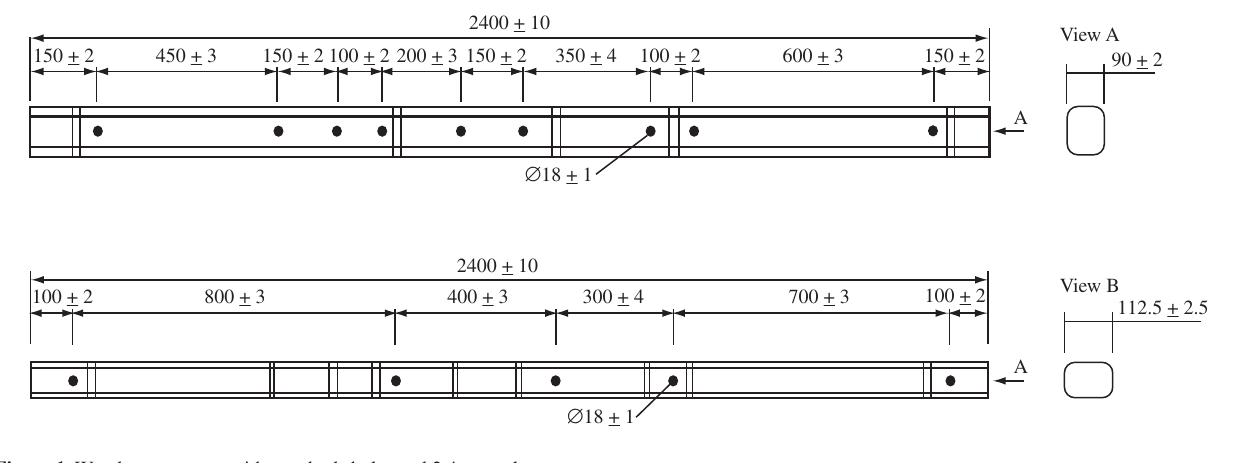
Figure 1. Wooden cross-arm with standards holes and 2.4 meter long.